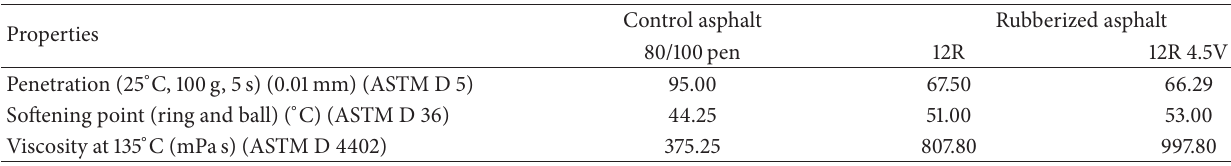
Table 2: Basic properties of asphalt and rubberized asphalt.